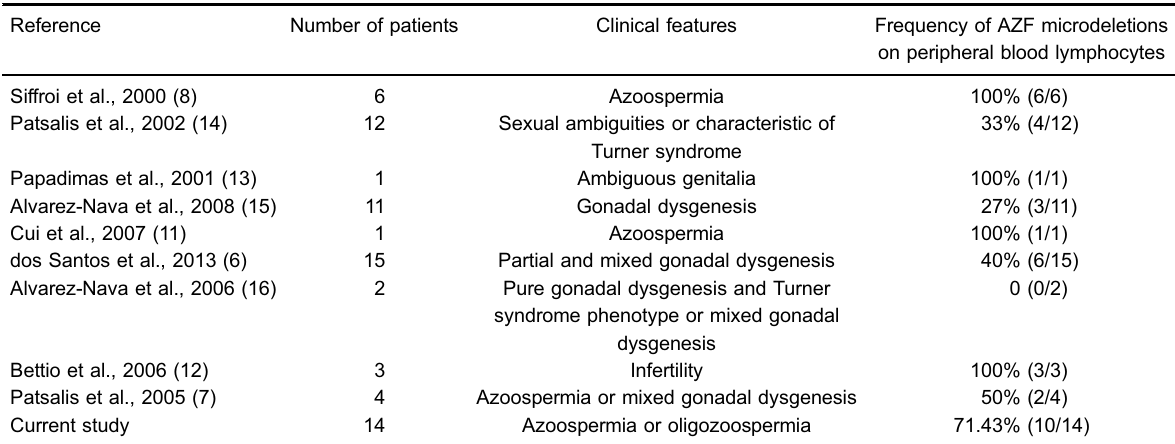
Table 1. Frequency of AZF microdeletions in men with 45,X/46,XY mosaicism or its variants reported in the literature.